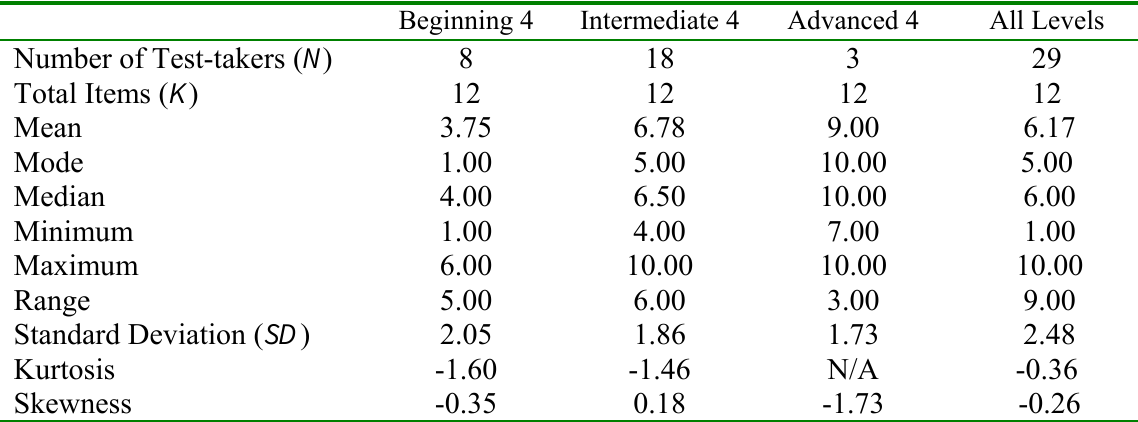
Descriptive Statistics of the Reading Ability Test by Proficiency Level Beginning